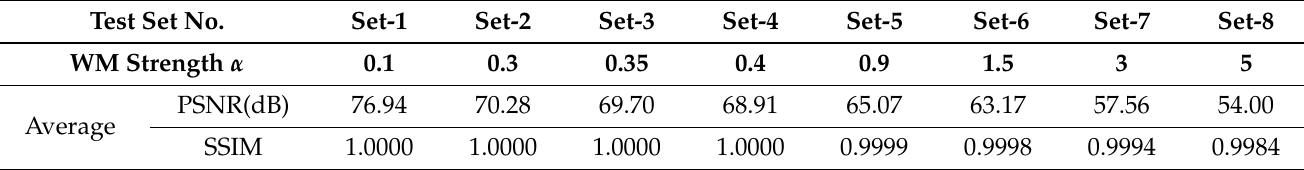
Figure 7. Quality assessment result for various watermark scale factor α . ( a ) PSNR, and ( b ) SSIM. Table 3. Evaluation result without video compression for original and watermarked